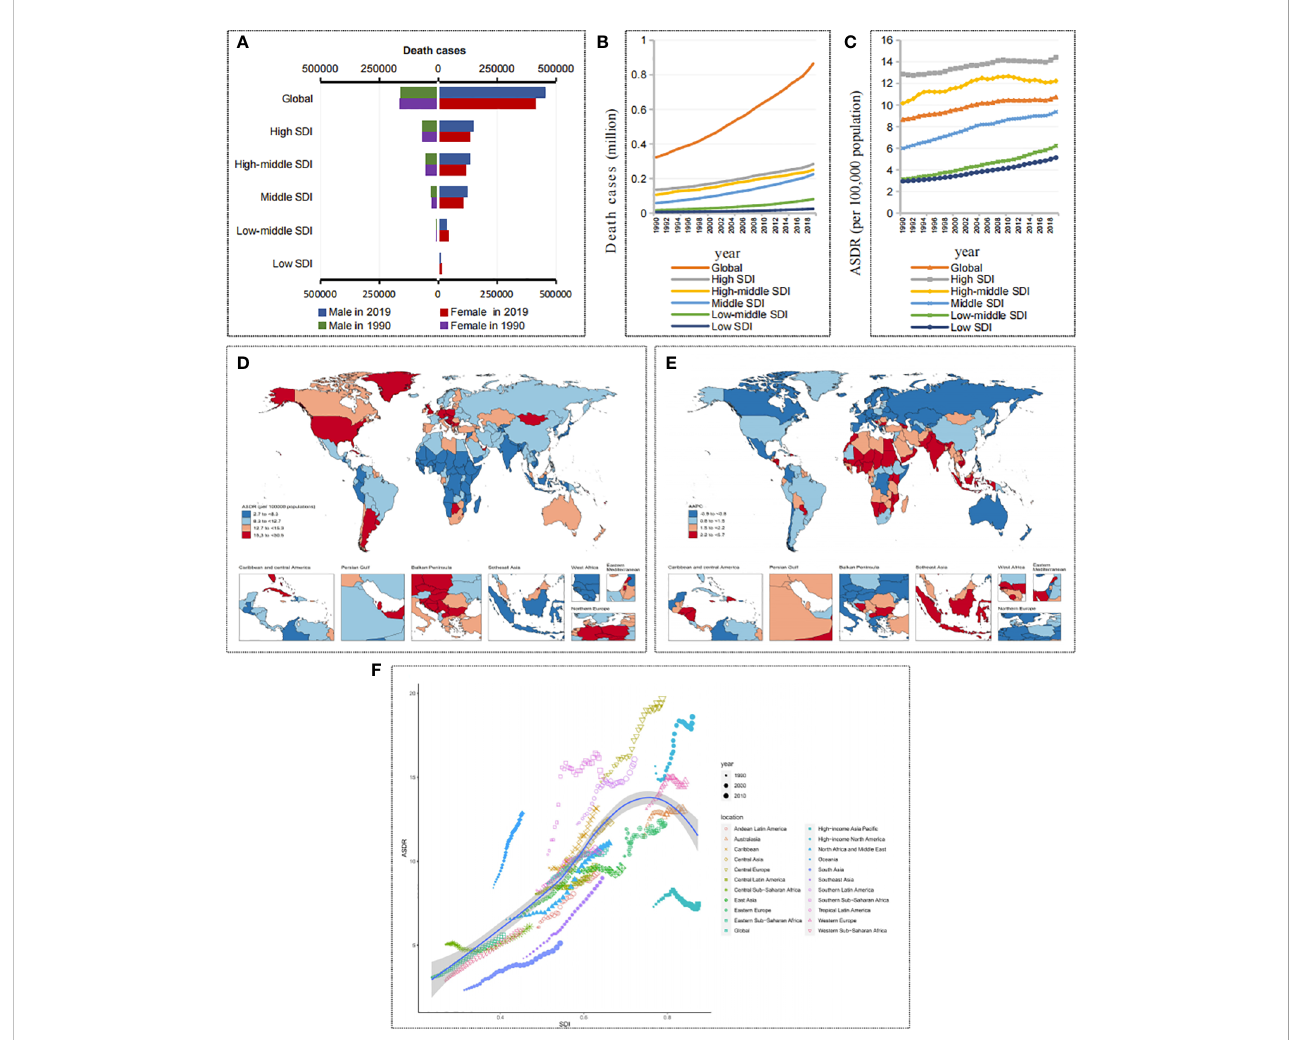
FIGURE 2 Death burden in cancers attributable to metabolic factors. (A) Death cases in cancers attributable to metabolic factors by SDIs and sexes in 1990 and 2019. (B) The trend of death cases in cancers attributable to metabolic factors by SDIs from 1990 to 2019. (C) The trend of ASDRs in cancers attributable to metabolic factors by SDIs from 1990 to 2019. (D) ASDRs of cancers attributable to metabolic factors by countries and territories in 2019. (E) AAPC of ASDRs in cancers attributable to metabolic factors by countries and territories from 1990 to 2019. (F) ASDRs of cancers attributable to metabolic factors by GBD regions from 1990 to